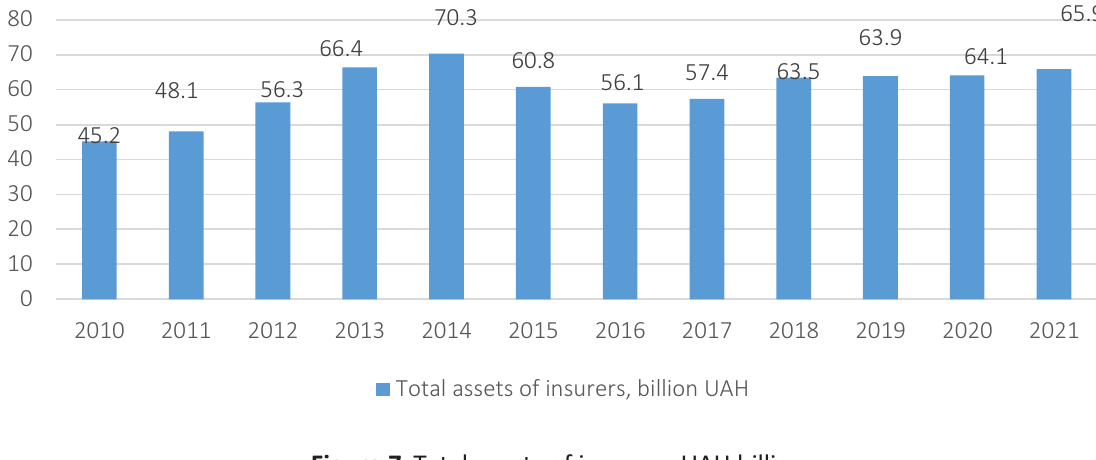
Figure 7. Total assets of insurers, UAH